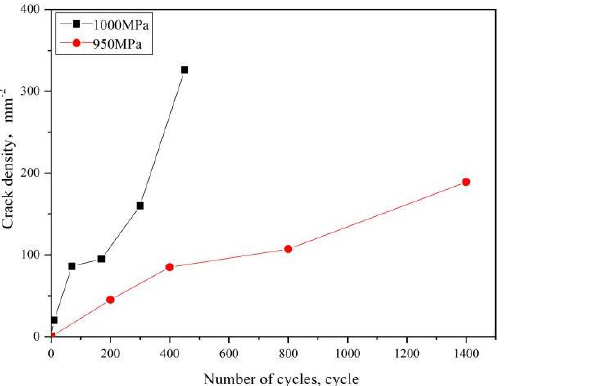
Figure 8 . Statistics early fatigue cracks under different stress amplitudes. ( a ) Crack density. ( b ) Maximum crack length.